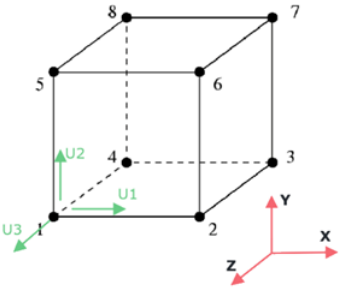
Figure 5. Cubic brick element (C3D8R).